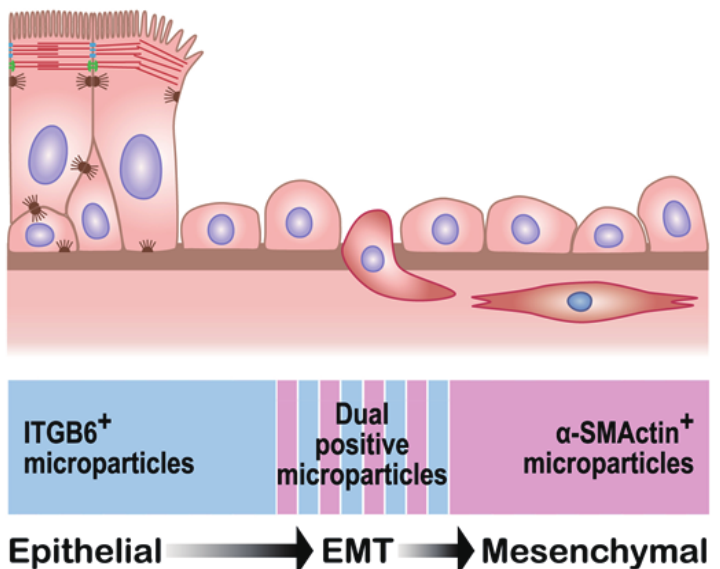
Figure 6. Hypothetical model of MP detection of basal cells/EMT. Differentiated epithelial cells (top left) transition to mesenchymal cells (lower right). During that process, the ITGB6-positive epithelial cells lose the epithelial marker and begin to express the mesenchymal marker α SMA (bottom). According to the hypothesis, dual-positive MPs are released only by cells that simultaneously express both markers (striped area, bottom).